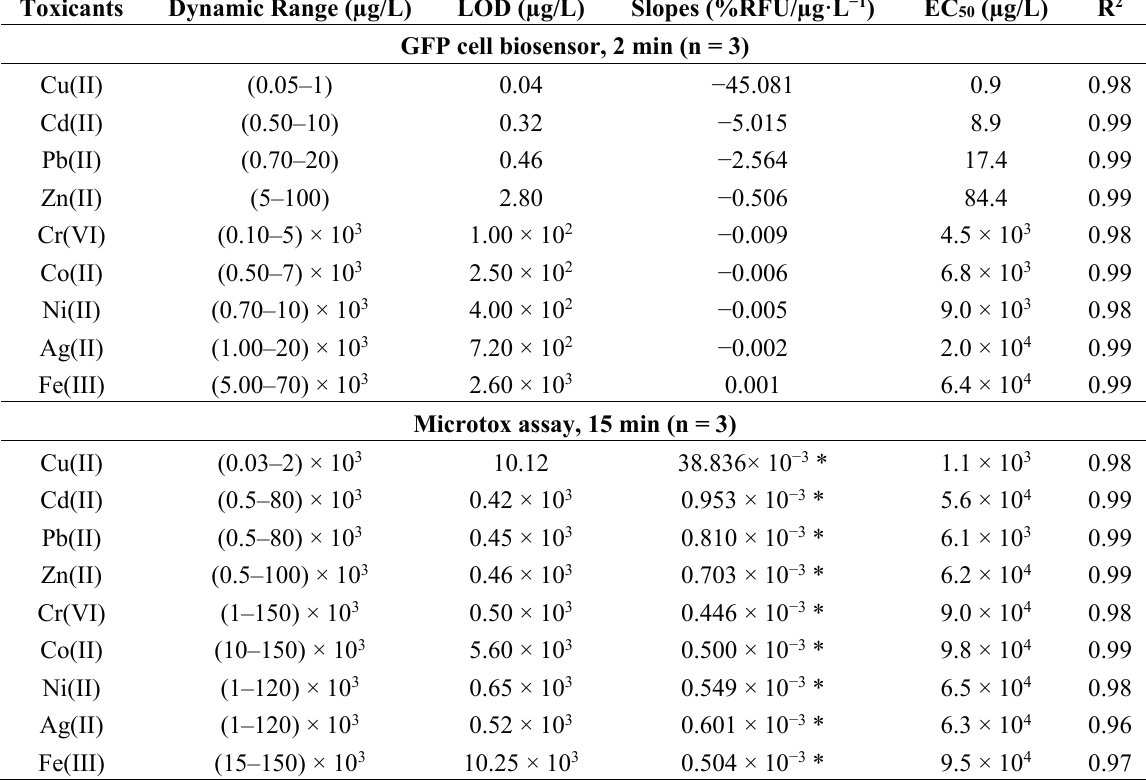
Table 1. The comparison between green fluorescent protein (GFP) E. coli biosensor and Mictotox method for the detection of various single toxicants. The bacterial cell concentration used had an optical density of 0.8 Abs OD at 600 nm. The Ca-alginate membrane was prepared from 4% alginate and 0.15 M CaCl 2